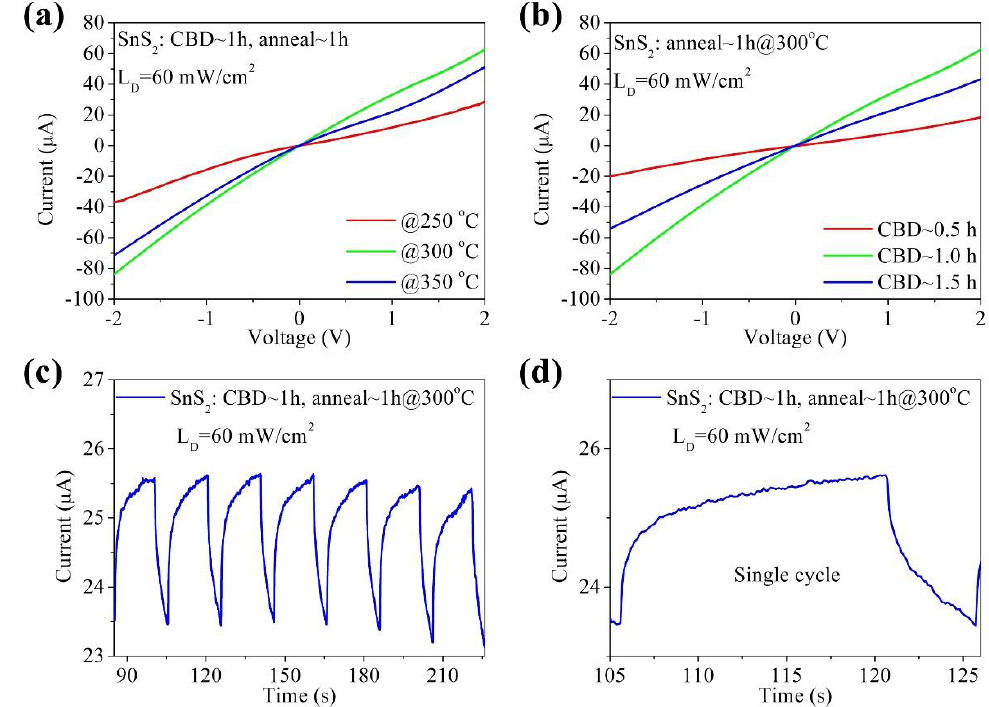
Figure 4. ( a ) I-V curves of photodetectors with different annealing temperatures under illumination intensity of 60 mW/cm 2 . ( b ) I-V curves of photodetectors with different CBD time. ( c ) I-t curves of photodetector with an on – off period of 20 s. ( d ) I-t curve of a single cycle of photodetector.